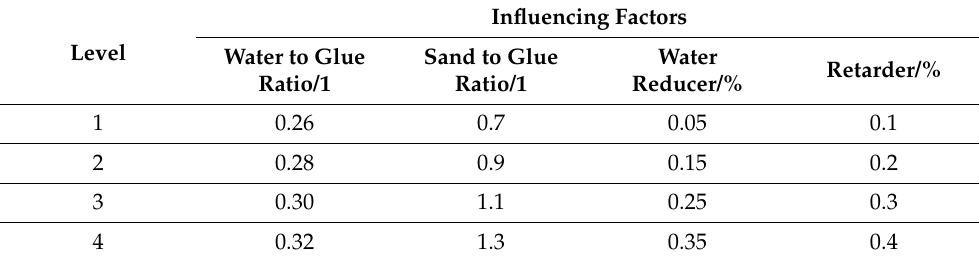
Table 5. Value of each influencing factor at different levels.